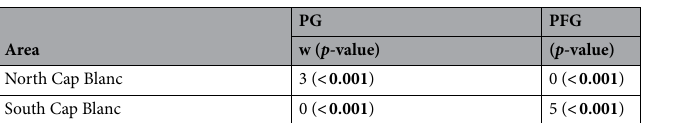
Table 3. Wilcoxon test comparing day and night differences in the acoustic abundance of the plankton group (PG) and pelagic fish group (PFG) in the areas north and south of Cap Blanc. w: Wilcoxon rank correlation coefficient; Significant values (p-value < 0.05) are shown in